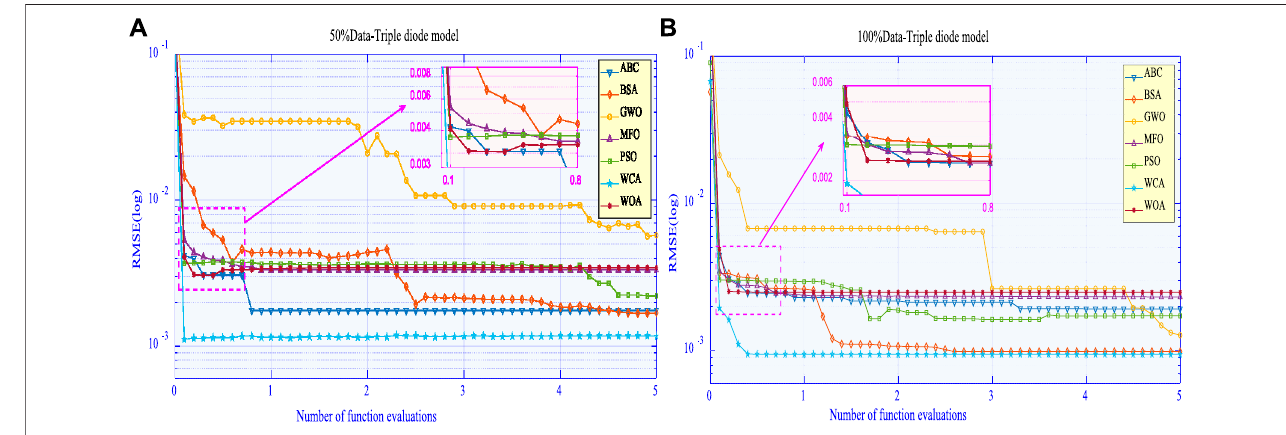
FIGURE 14 | Convergence of different algorithms for the TDM: (A) 50% data and (B) 100% data.